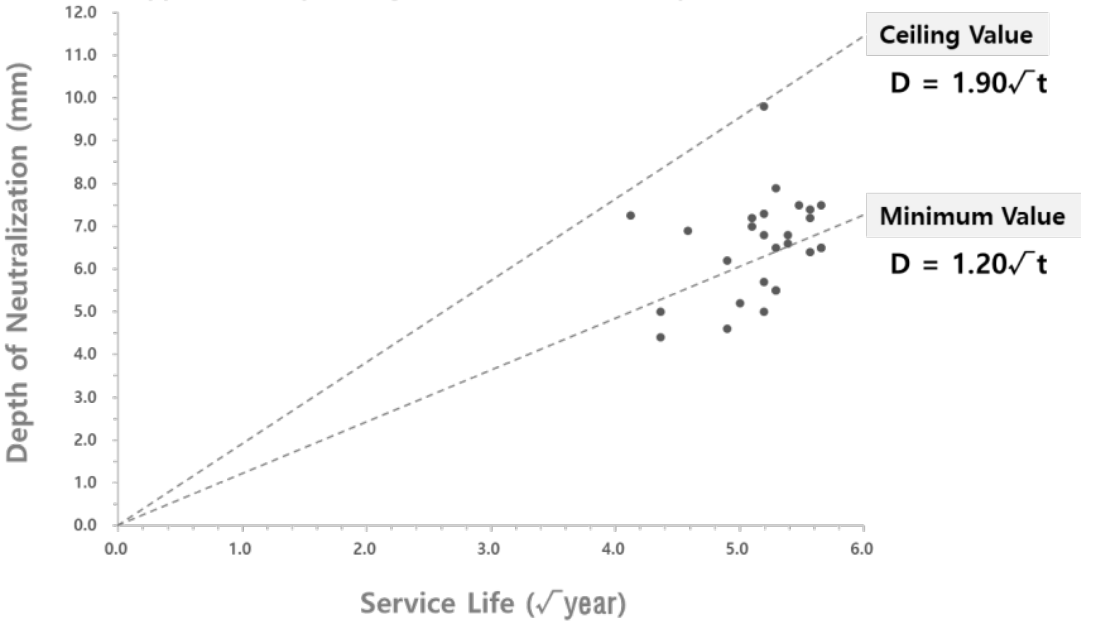
Figure 5. Carbonation depth distribution on the inner wall of the water reservoirs (waterproof- ing/anticorrosive method applied after 10 years of service life) - according to the theoretical equation